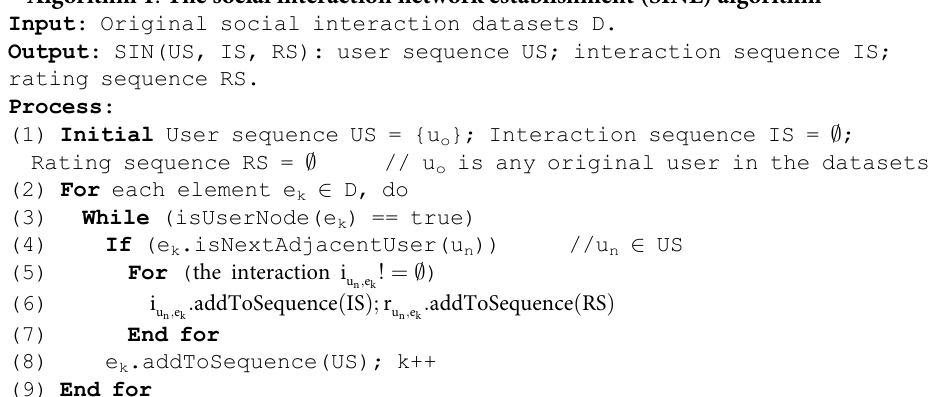
Algorithm 1 : The social interaction network establishment (SINE)